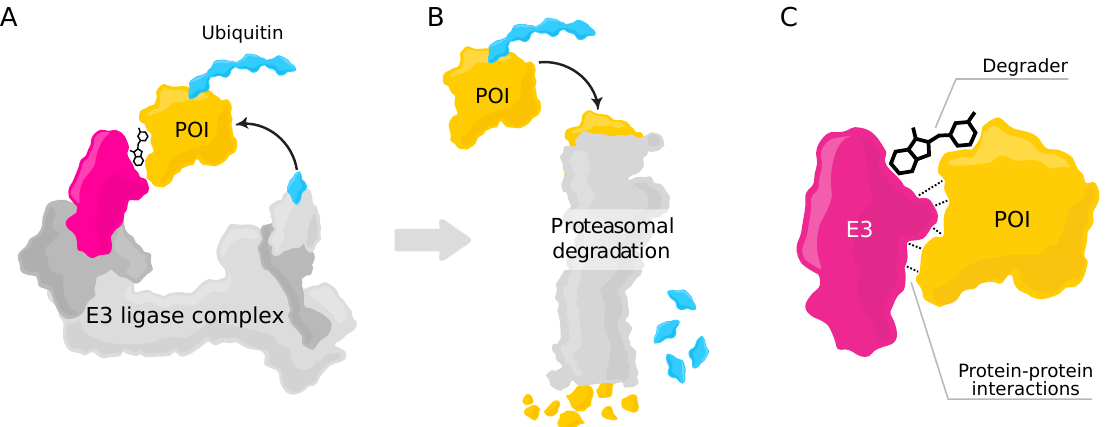
Figure 1. The relevance of protein–protein interactions for targeted protein degradation with bifunc- tional degraders. ( A ) To accomplish targeted protein degradation, the protein of interest (POI, yellow) is linked to the receptor (magenta) of an E3 ligase complex via a degrader molecule. Together, the POI, degrader, and E3 ligase form a ternary complex, allowing the passage of ubiquitin to the POI. ( B ) Ubiquitination of the POI leads to its degradation via the proteasomal system. The ubiquitin is recycled. ( C ) While the degrader molecule is instrumental for bringing the two proteins into prox- imity, cooperativity between the E3 ligase and the POI—i.e., strong protein–protein interactions—is essential for the formation of a stable ternary